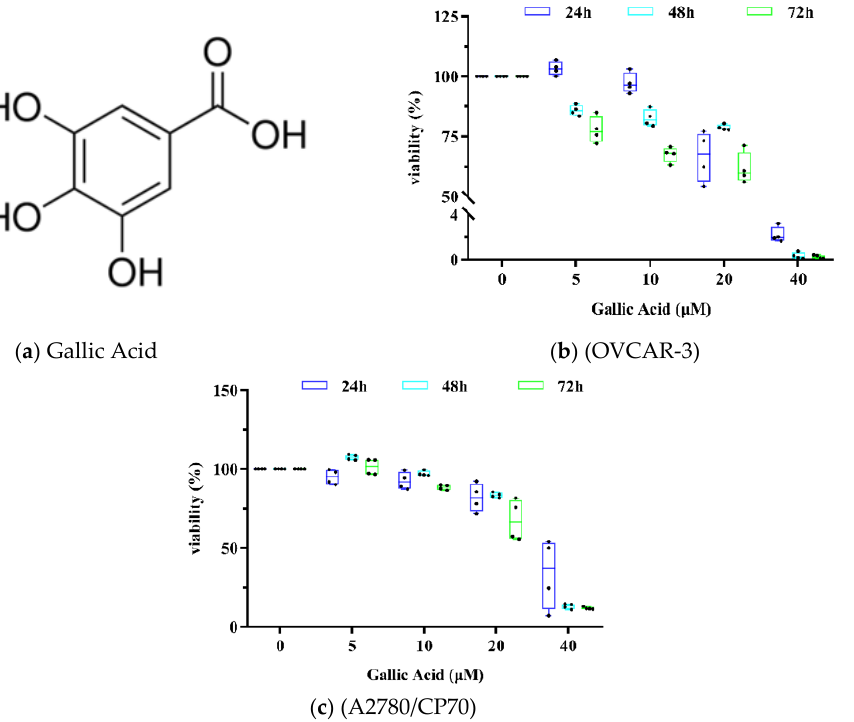
Figure 1. GA suppresses OC cell proliferation. ( a ) Structure of GA. ( b ) GA inhibited OVCAR-3 cell viability. ( c ) GA inhibited the A2780/CP70 cell